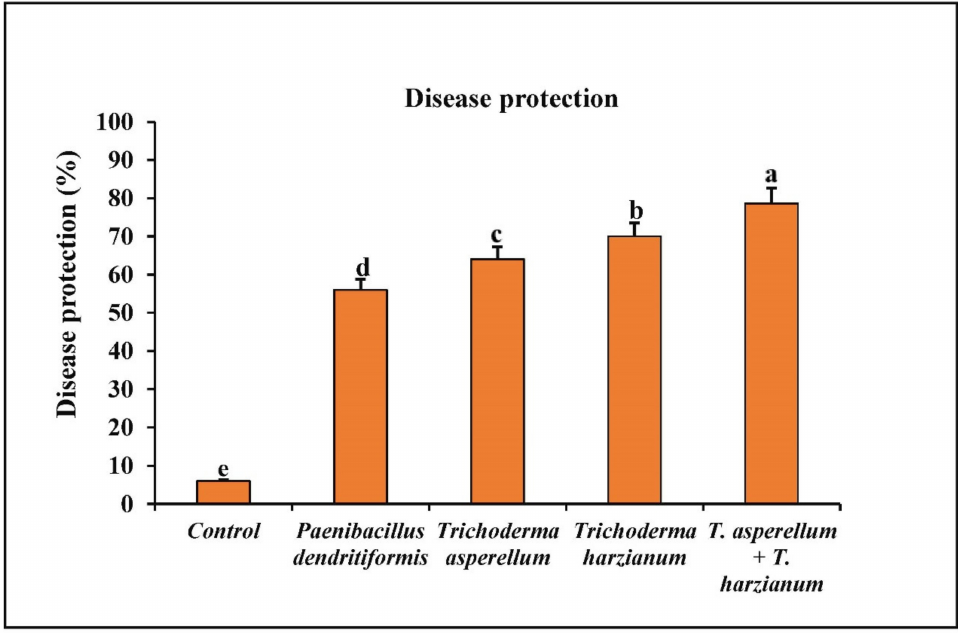
Figure 8. The treatment of chilli with T. harzianum, T. asperellum, and P. dendritiformis showing protection against anthracnose disease in the greenhouse experiment. Each value is expressed as the mean of triplicates, and the bars sharing the same alphabetical letters are not significantly different ( p ≤ 0.05) using Duncan’s multiple range test. The vertical bar designates the standard